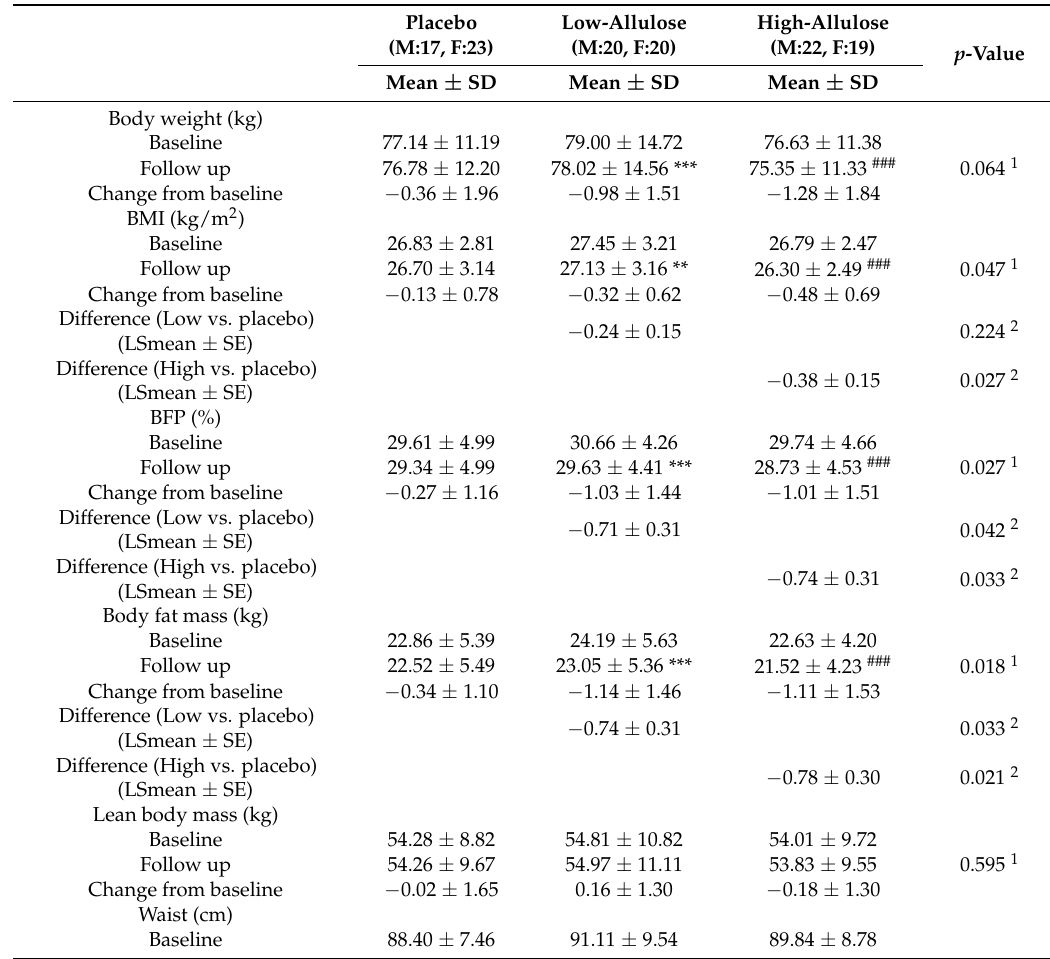
Table 4. Dose-dependent effect of D -allulose supplementation for 12 weeks on BMI, BFP, body fat mass, lean body mass, WHR-related body measurements, and blood pressure in overweight or obese